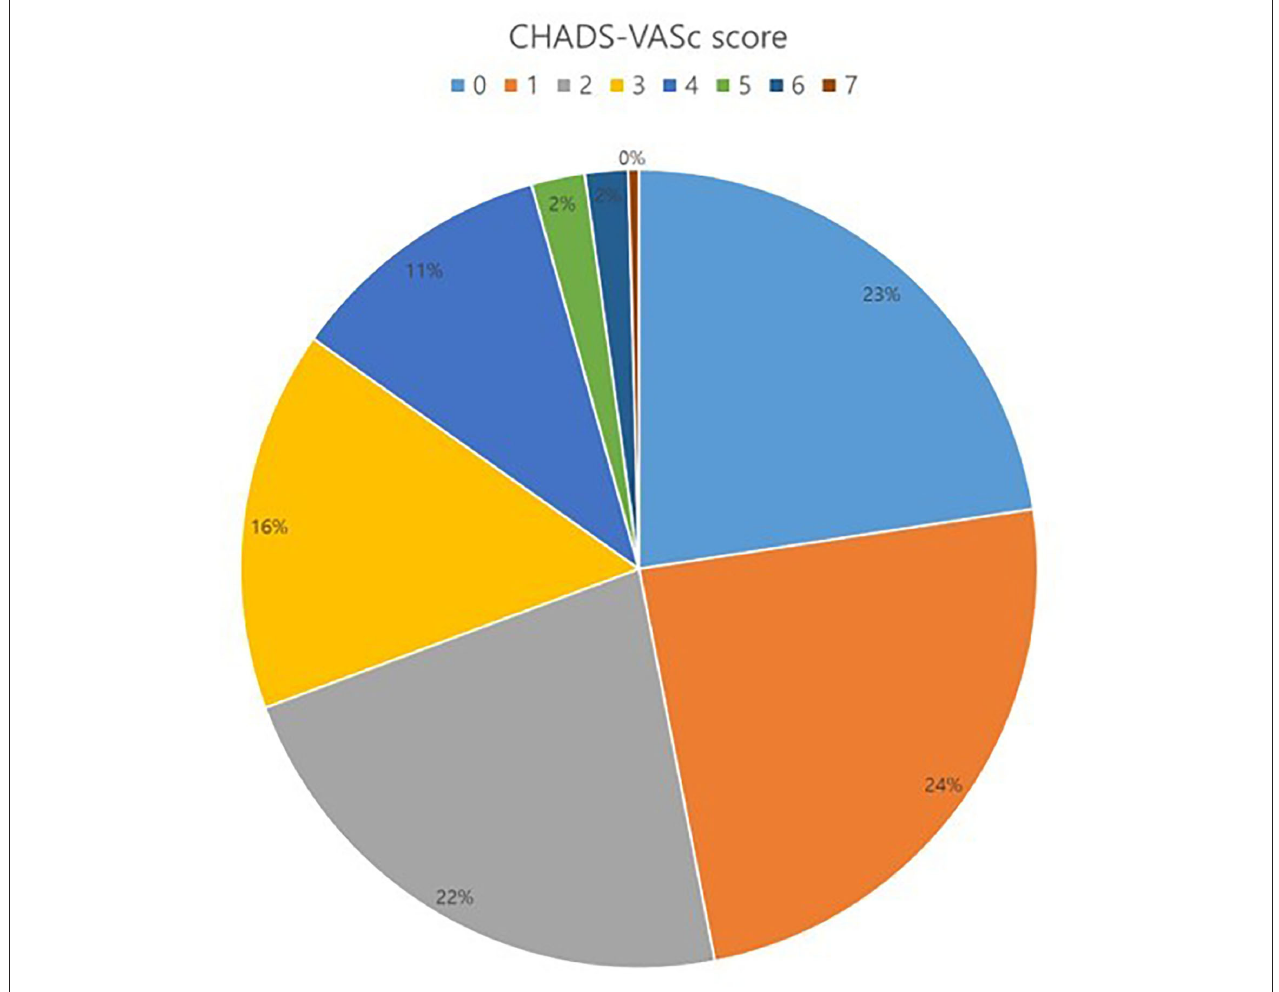
FIGURE 3 | Distribution of CHA 2 DS 2 -VASc